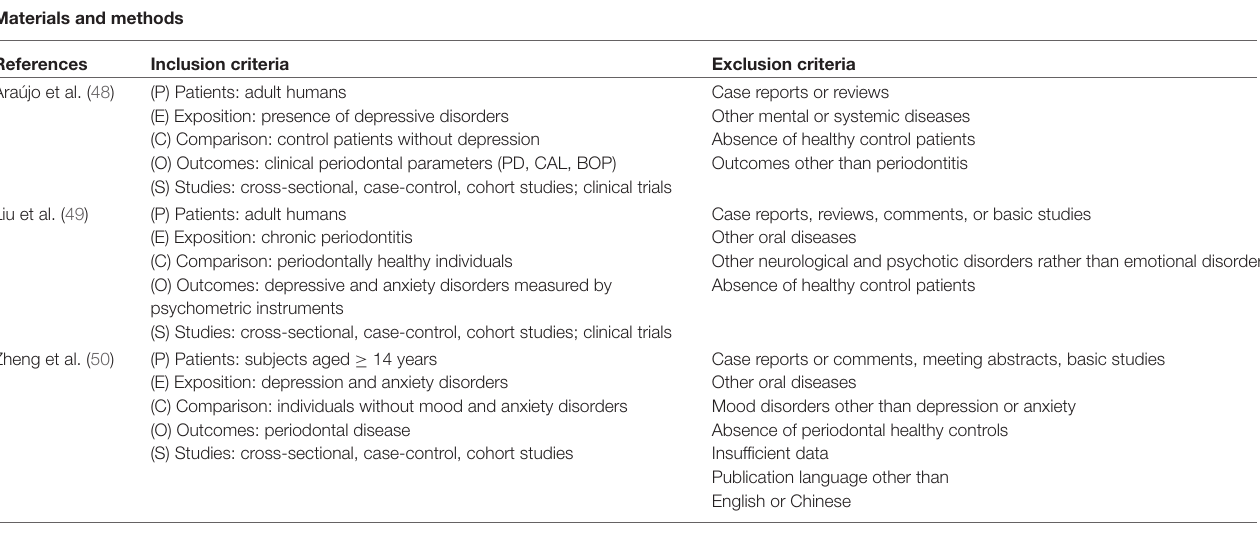
TABLE 1A | Main characteristics of systematic reviews dealing with the association between periodontitis and depression: material and methods.